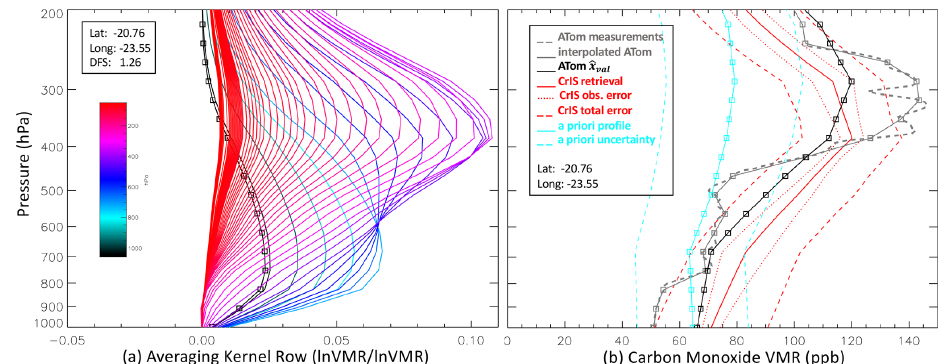
Figure 3. Examples of TROPESS/CrIS CO averaging kernel ( A ) (a) and the validation process (b) . The colors of the averaging kernel indicate the pressure level (66 levels from 1017.45 to 0.1hPa) corresponding to each row, with the surface-level row also indicated by the squares. The number of degrees of freedom for signal (DFS), given by the sum of the diagonal (i.e., trace) of this averaging kernel, is 1.26. The right panel shows the CrIS CO profile retrieval (solid red line) with total error (dashed red lines), observation error (dotted red lines), a priori profile (solid cyan line with squares), and diagonal uncertainty (dashed cyan lines). The closest ATom aircraft profile had 10.4km–3.5h coincidence. The original ATom profile (dashed grey line) is interpolated to the CrIS vertical grid (solid grey with squares) and transformed by the instrument operator to give ATom ˆ x val (Eq. 1) (solid black line with